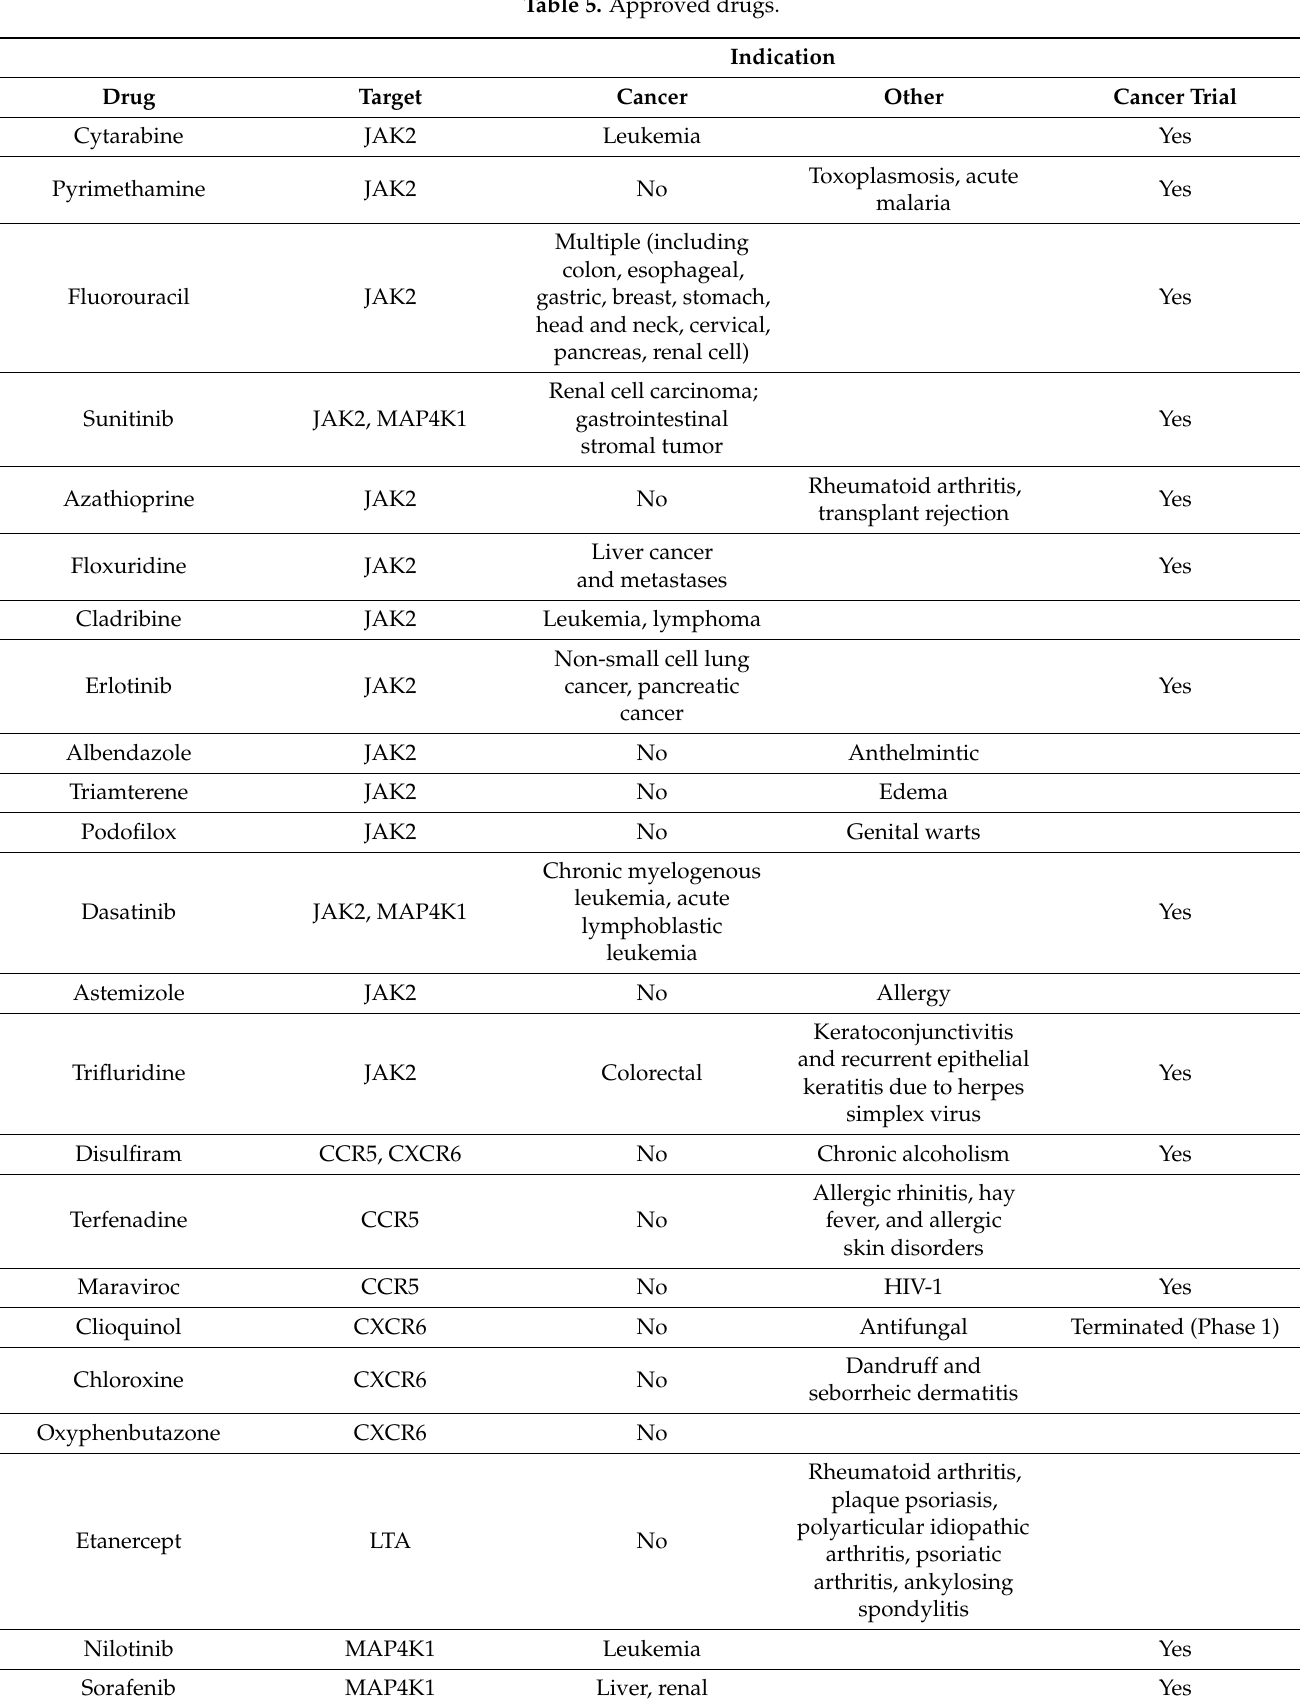
Table 5. Approved